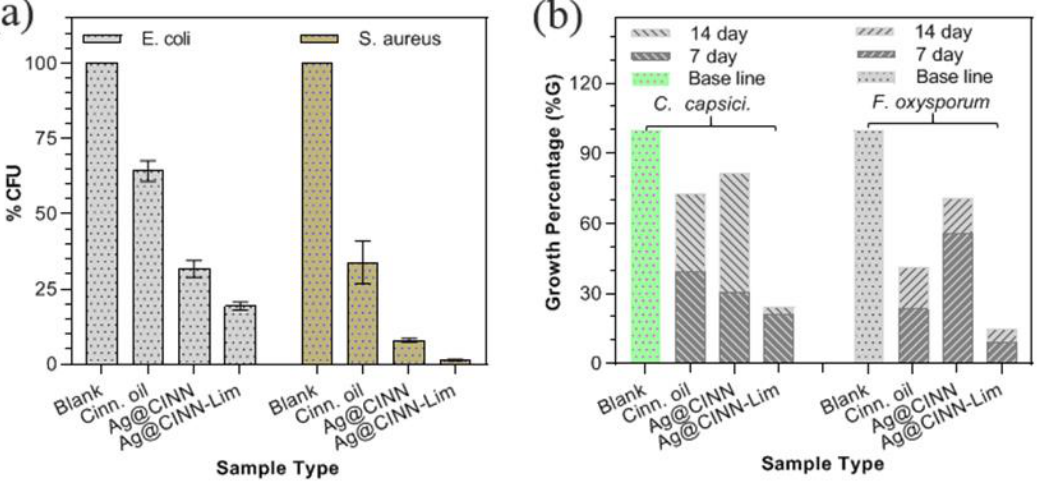
Figure 5. The growth percentage of our tested samples Ag@CINN and Ag@CIMM-Lim with controls ( a) against bacteria ( b ) against fungi.